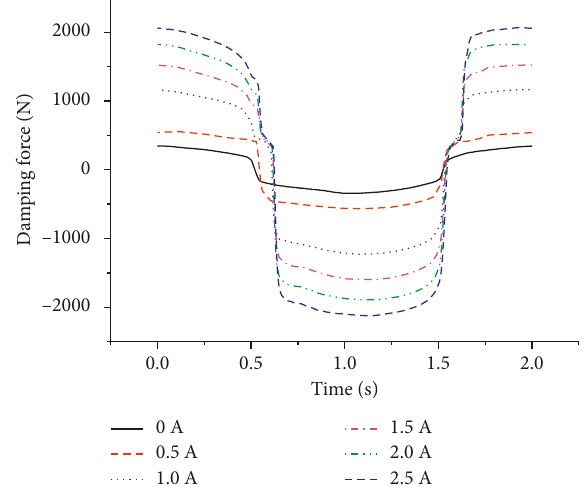
Figure 11: Experimental curves of a self-designed MR A comparison of the simulation results and experimental